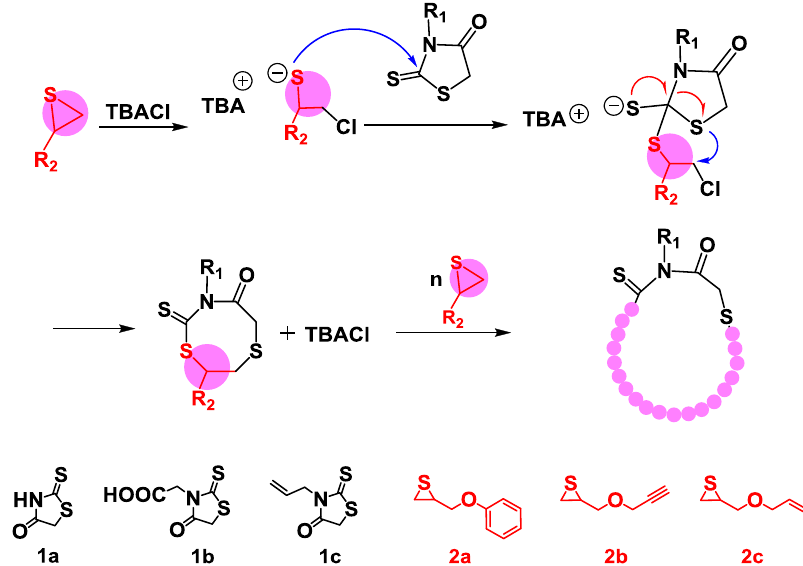
Fig. 1 Schematic illustration of the synthesis of cyclic polymer. Rhodanines initiate the anionic ring-opening polymerization (AROP) of thiiranes catalyzed by tetrabutylammonium chloride (TBACl) at 75